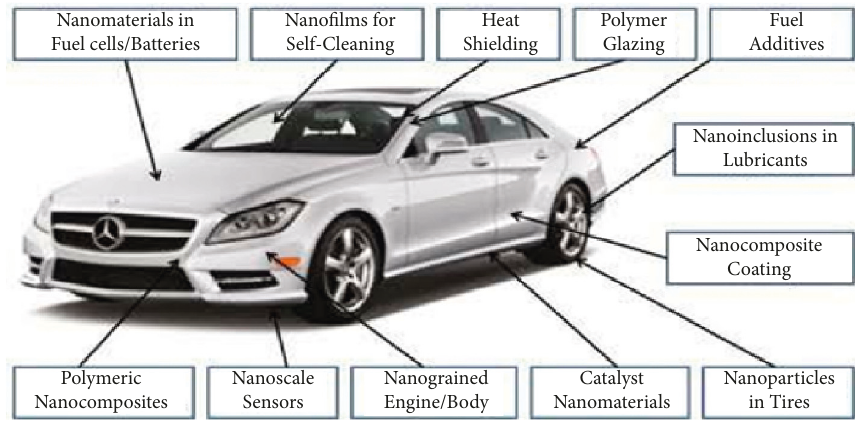
Figure 12: Current application areas of nanofluids in the automobile industry